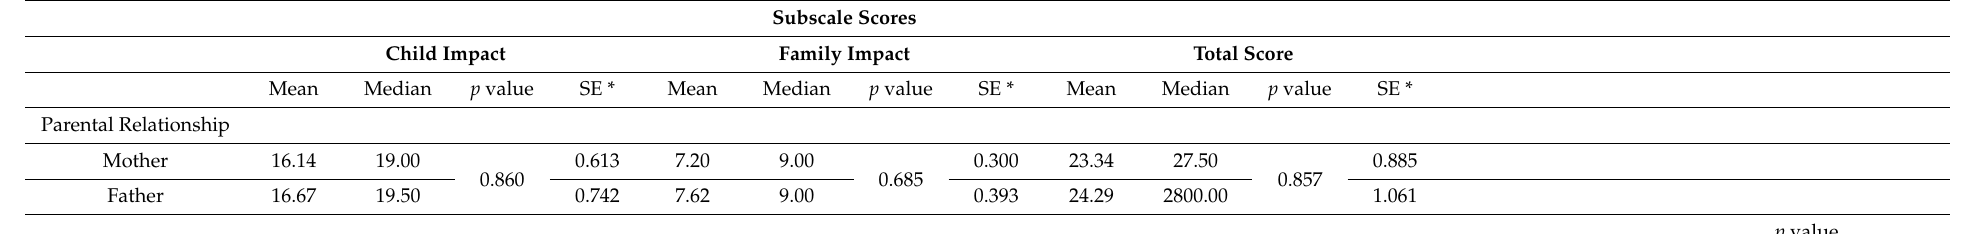
Table 6. Association between overall and subscales scores of Early Childhood Oral Health Impact Scale Responses (ECOHIS) and demographic